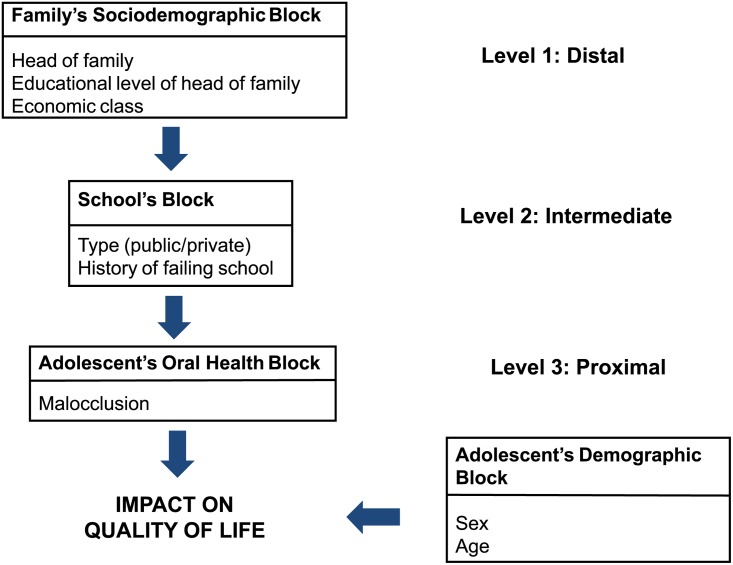
Theoretical model.